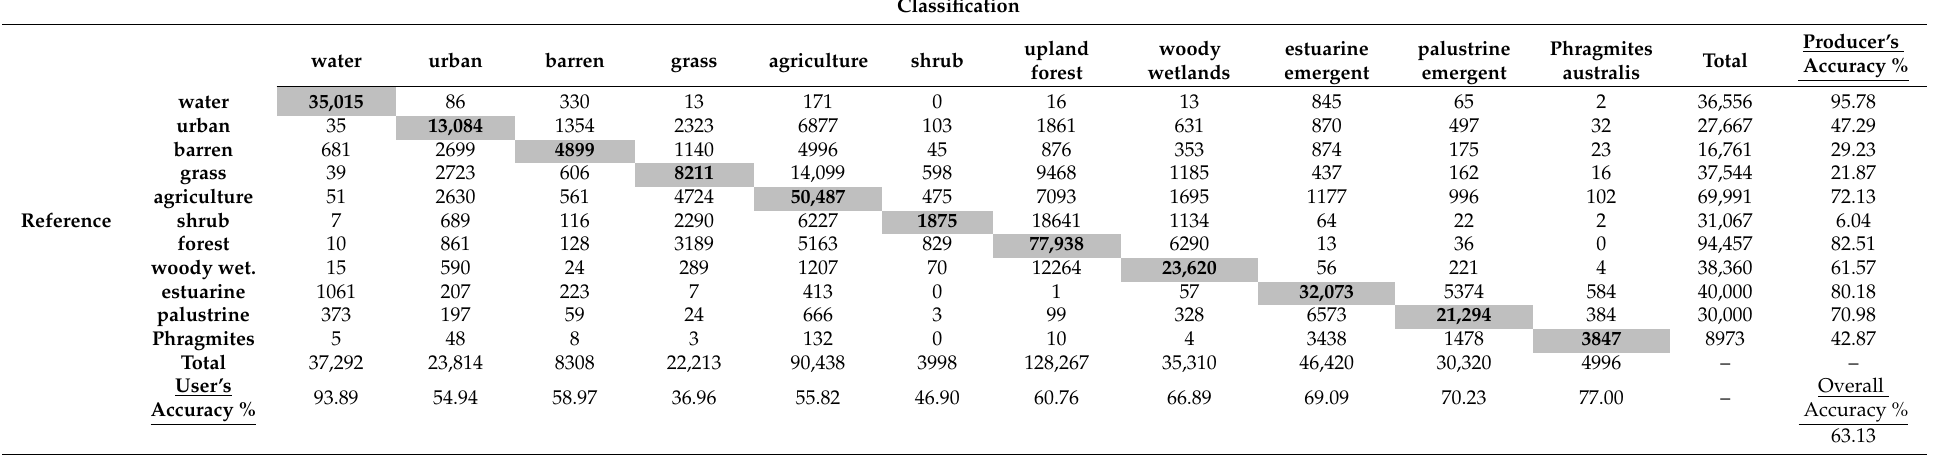
Table 3. Gulf Coast level-1 random forest classification confusion